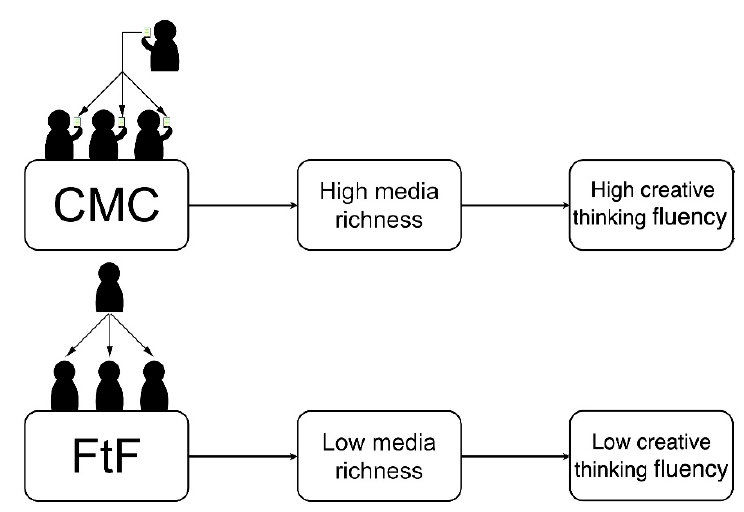
Figure 1. Research hypothetical model (e.g., media richness vs. creative thinking fluency) of the hypnotized impact on creativity potential after creative training by media richness.